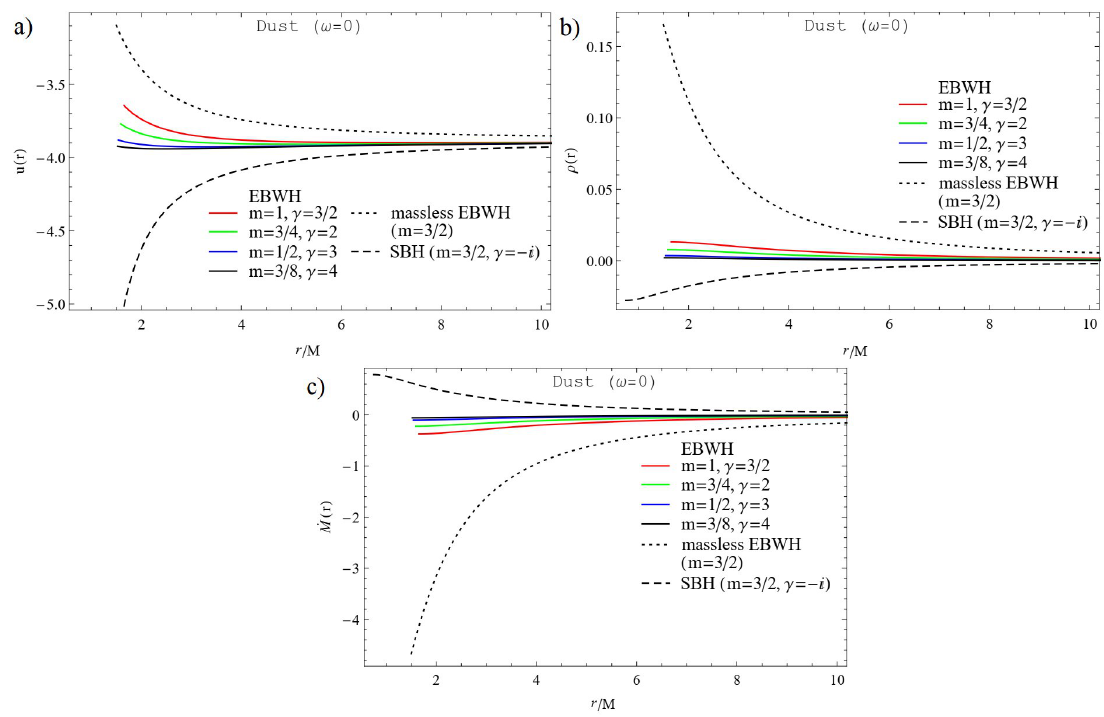
for for M M for M 1, A 2 = 1, 1, A 2 = 1, − − − − 1, A 2 = 1, − −